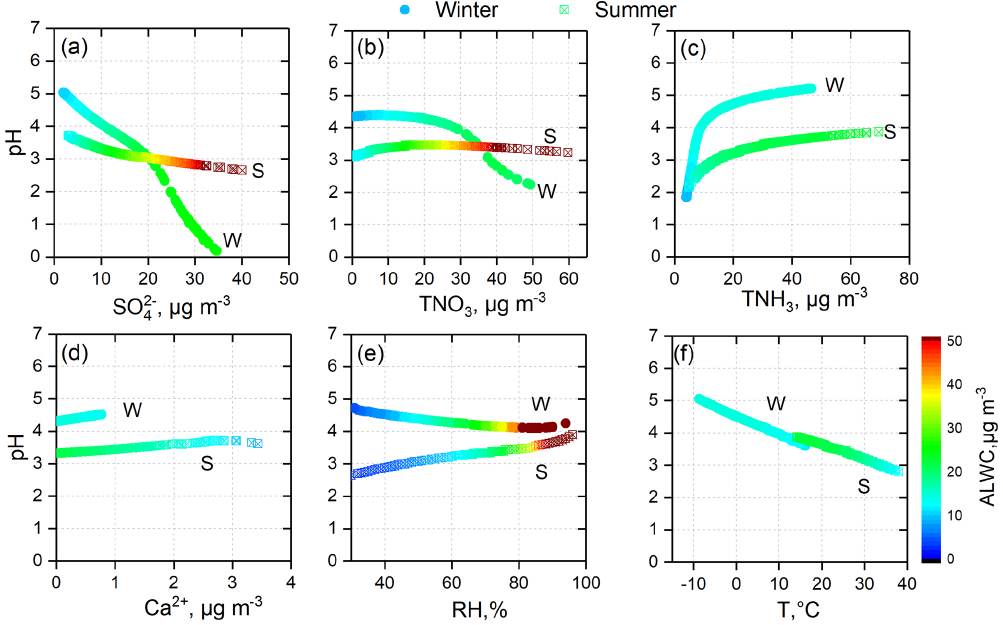
Figure 7. Sensitivity tests of PM 2 . 5 pH to SO 2 −